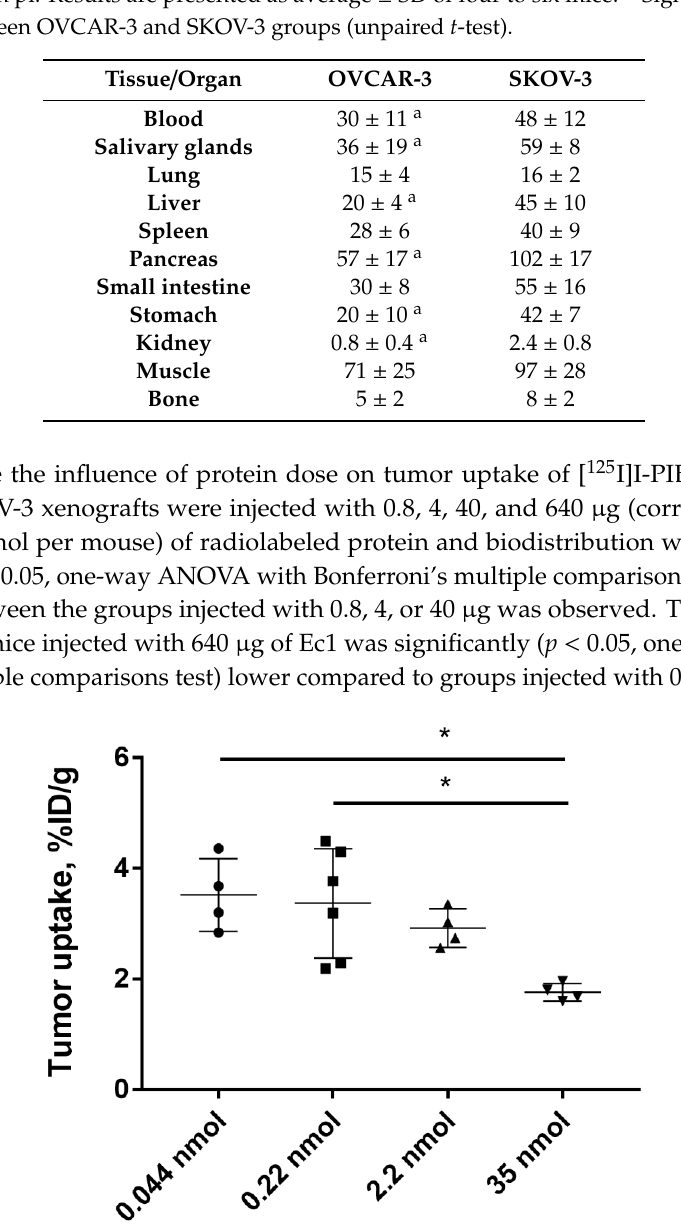
Figure 6. Tumor uptake of [ 125 I]I-PIB-Ec1 in Balb/c nu/nu mice bearing SKOV-3 xenografts injected with 0.8, 4, 40, or 640 µg (corresponding to 0.044, 0.22, 22, and 35 nmol) total protein amount 6 h pi. Asterisks show significant differences ( p < 0.05, one-way ANOVA with Bonferroni’s multiple comparisons test) between the groups.